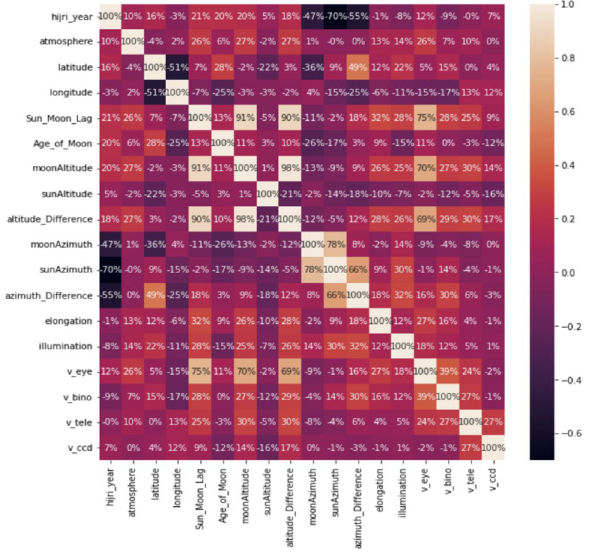
Figure 10. The heatmap showing correlation between features of the dataset. Python 3.6.9, Collab URL: https:// colab. resea rch. google.